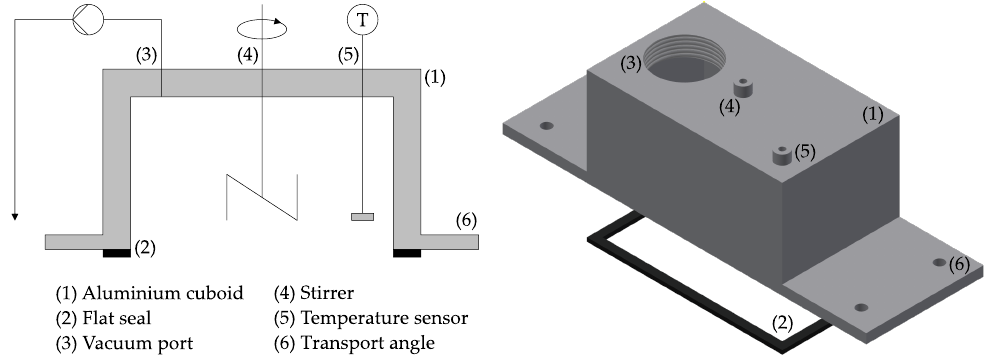
Figure 2. Schematic (left) and CAD drawing (right) of the process chamber. The component consists of a rectangular aluminum cuboid (1), a flat seal (2) and connections for vacuum (3), stirring tool (4) and temperature sensor (5). The front sides are provided with angles to ensure exact positioning and transport